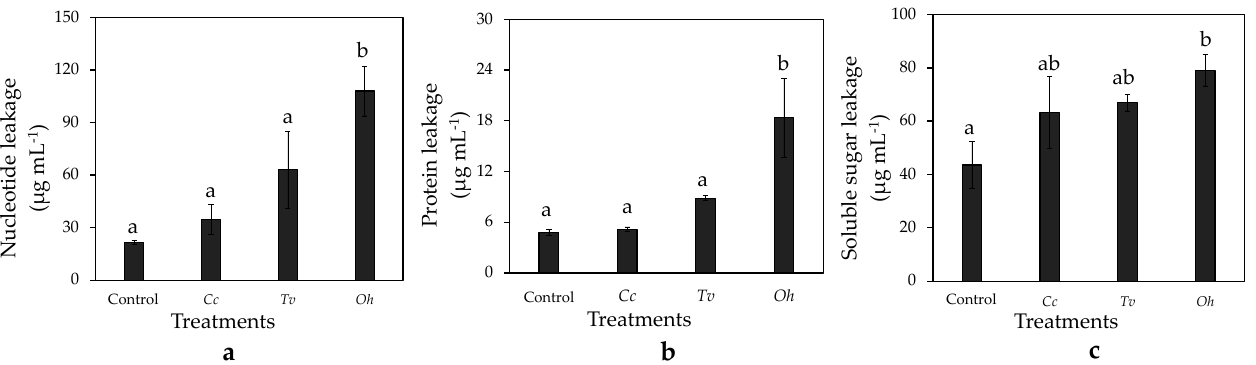
Figure 4. Effects of essential oils from Cymbopogon citratus ( Cc ), Thymus vulgraris ( Tv ), and Origanum heracleoticum ( Oh ) essential oil on leakage of nucleic acids ( a ), proteins ( b ), and soluble sugars ( c ) of Botrytis cinerea mycelium. Each value represents the mean of ten replicates. Means with different letters are significantly different based on Ducan’s test ( p ≤ 0.05).